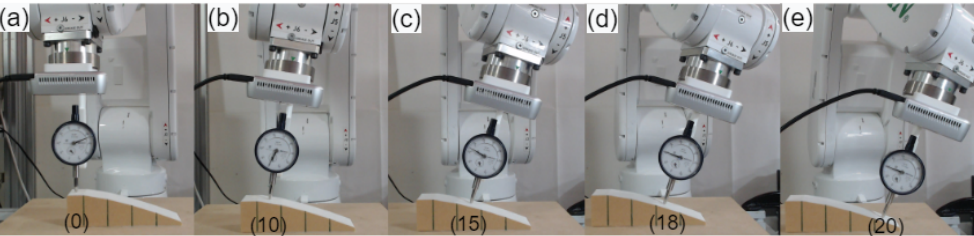
Figure 11. Single point normal estimation on the customized workpiece. ( a – e ) Shows correction of robot angles on customized workpiece with varying angle offsets (0°, 10°, 15°, 18°,